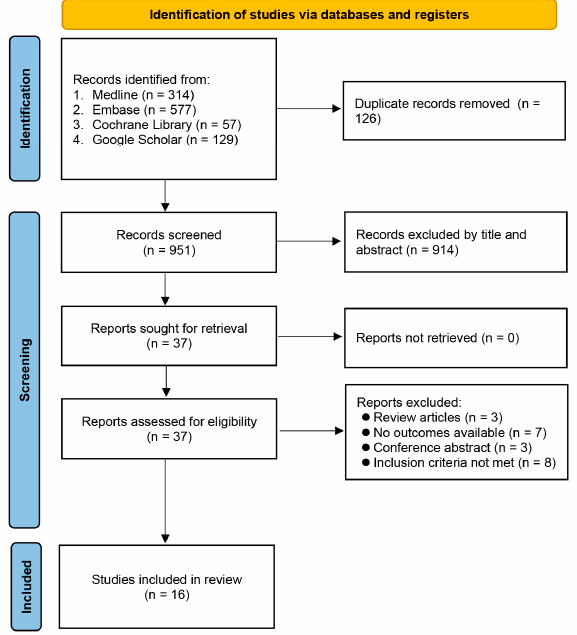
Figure 1. PRISMA flow diagram of study selection.